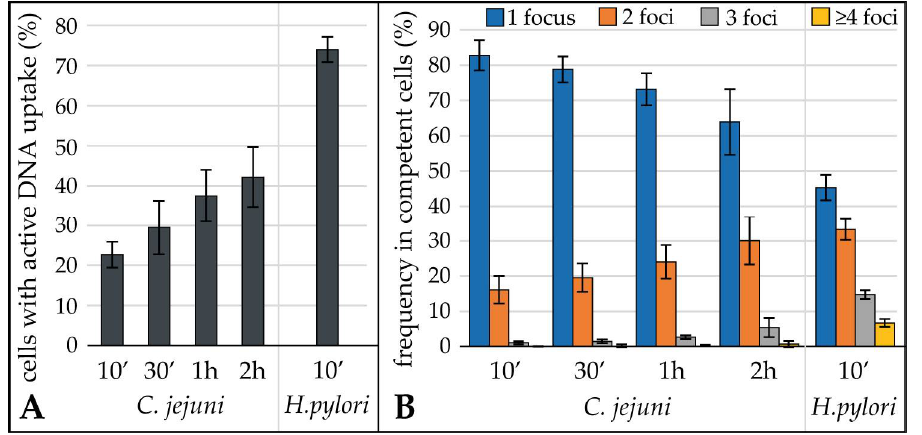
Figure 2. The fraction of competent C. jejuni and of DNA uptake locations per cell increased in time of contact with fluorescent DNA. Competent C. jejuni 81–176 were exposed to fluorescent DNA for different time periods and the fraction of cells with active DNA uptake was monitored in comparison to 10 min DNA uptake in H. pylori J99 ( A ). Proportion of cells with distinct number of DNA uptake locations ( B ). In ( B ), fraction of cells relative to total amount of competent cells are depicted. Mean and standard deviations were derived from five independent experiments.